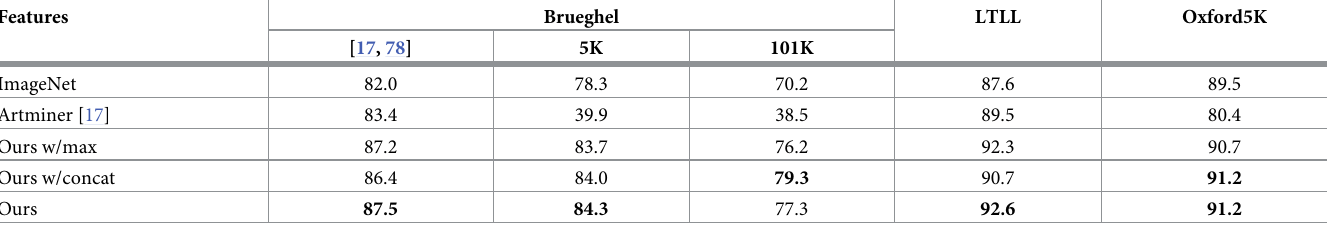
Performance comparison of the retrieval algorithm with the multi-style features (Ours) against pre-trained ImageNet (ImageNet) and fine-tuned Artminer (Artminer) features. Additionally, we compare different aggregation strategies, including taking the max (w/max), concatenating (w/concat), and averaging over the